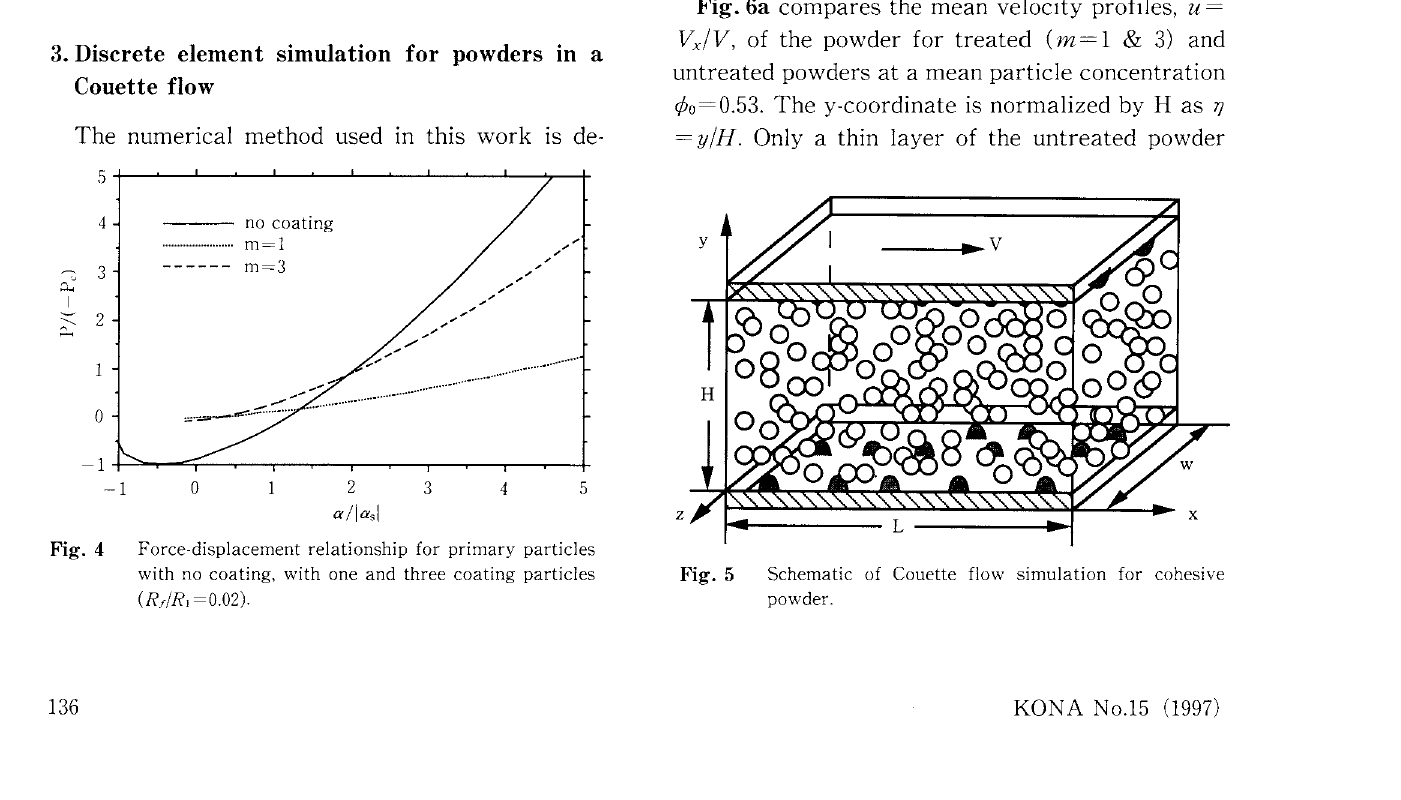
Fig. 6a compares the mean velocity profiles, u = Vx/V, of the powder for treated ( m = 1 & 3) and untreated powders at a mean particle concentration = y/H. Only a thin layer of the untreated powder